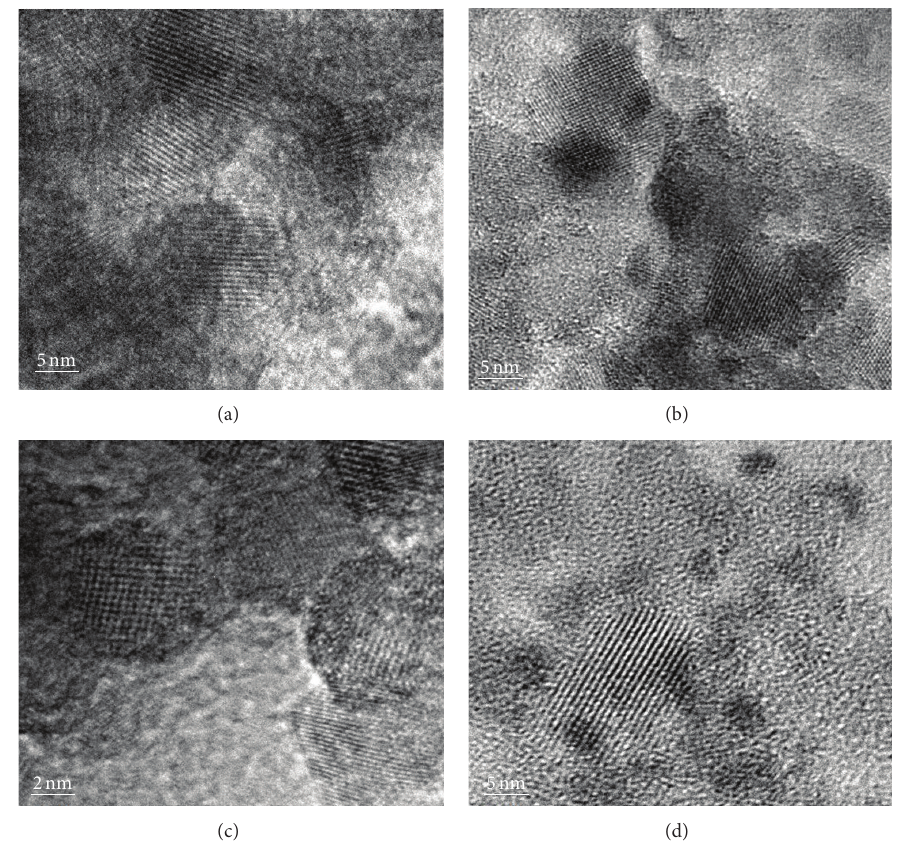
Figure 3: HRTEM images of the Pd and Pt catalysts prepared by IMP and MOCVD methods. (a) Pd-IMP, (b) Pd-MOCVD, (c) Pt-IMP, and (d) Pt-MOCVD catalysts.